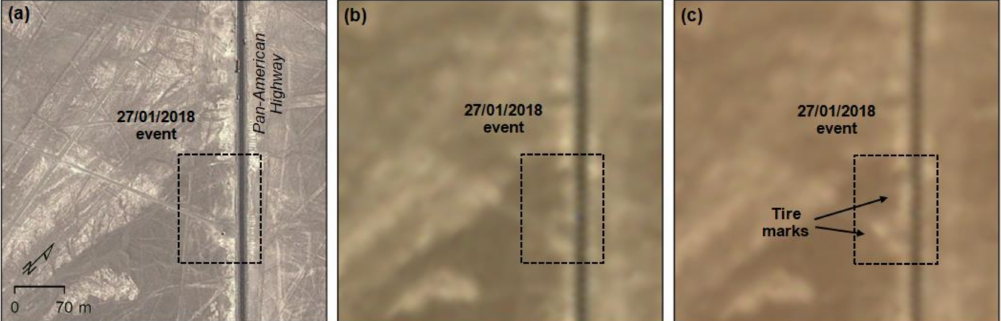
Figure 5. ( a ) Google Earth overview of the area where the 27/01/2018 incident occurred (VHR image © 2018 DigitalGlobe), and ( b , c ) comparison of Sentinel-2B: ( b ) pre-event (18/01/2018); and ( c ) post-event (28/01/2018) true colour images (Copernicus Sentinel-2 data © 2018 European Space Agency, ESA). The deep tire marks left by the truck during the incident are indicated in the post-event scene, which shows a local increase in surface